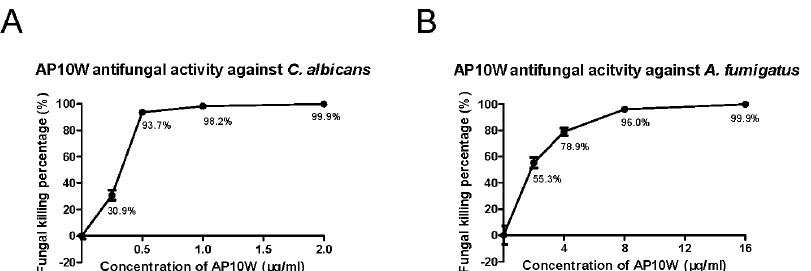
Figure 1. In vitro antifungal activity of AP10W. ( A ) Antifungal activity against C. albicans by AP10W